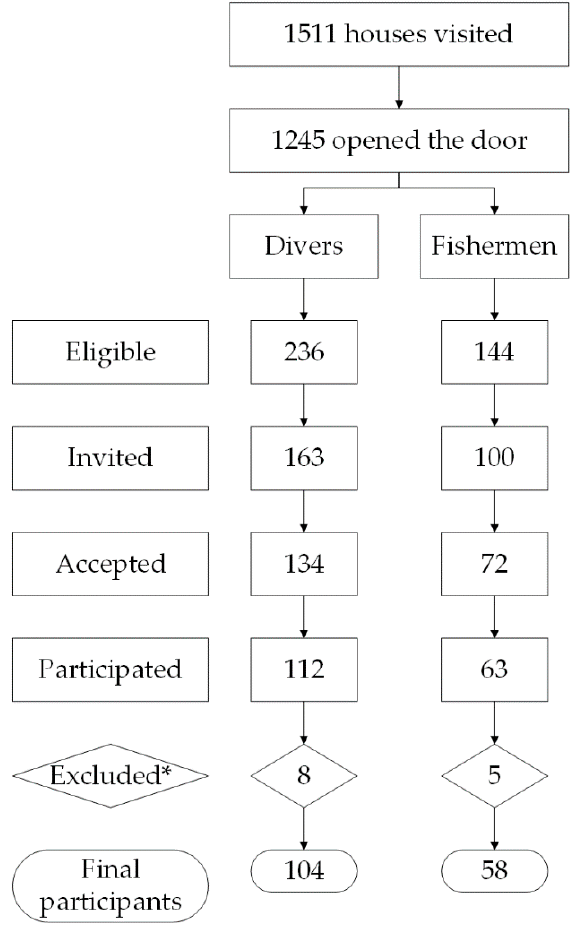
Figure 1. Participants and recruitment process in both communities. * Excluded for (1) having had a stroke or a diagnosis of current psychiatric illness, and (2) failure to complete WCST or records thereof could not be evaluated.